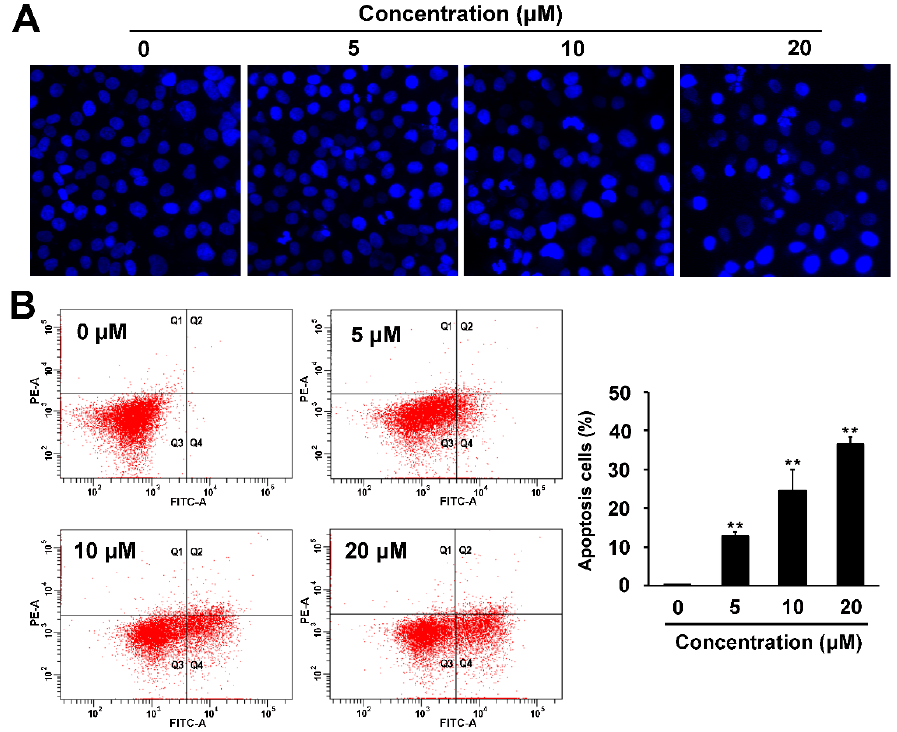
Figure 5. Cont Figure 5. Cont . Figure 5. Cont .